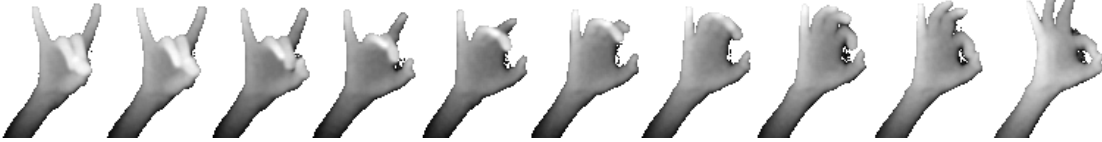
Figure 2. Several consecutive depth maps showing an exemplary transition from the letter Y to the letter